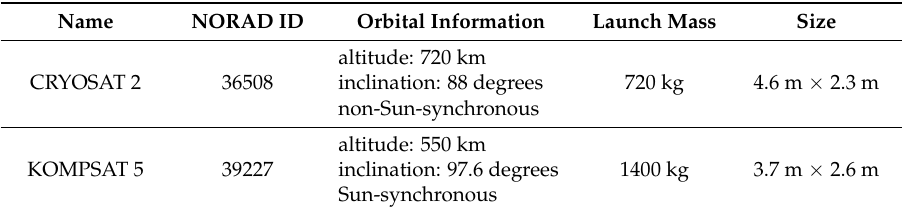
Table 1. Orbital and physical characteristics of low Earth orbit (LEO) targets.